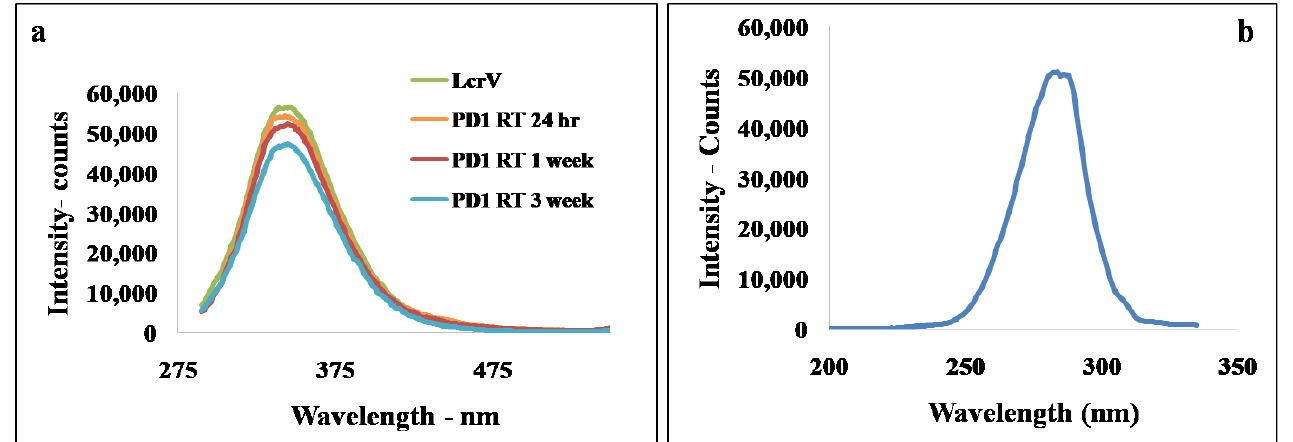
Figure 3. Fluorescence spectroscopic images showing ( a ) emission spectra of samples excited at 278 nm ( b ) excitation spectra with emission monochromator set at 345 nm.